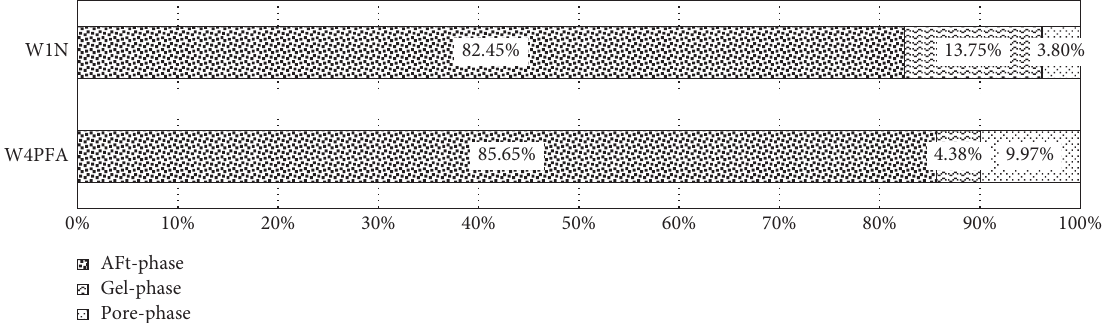
Figure 20: Volume proportion of phases of NCG concretion by